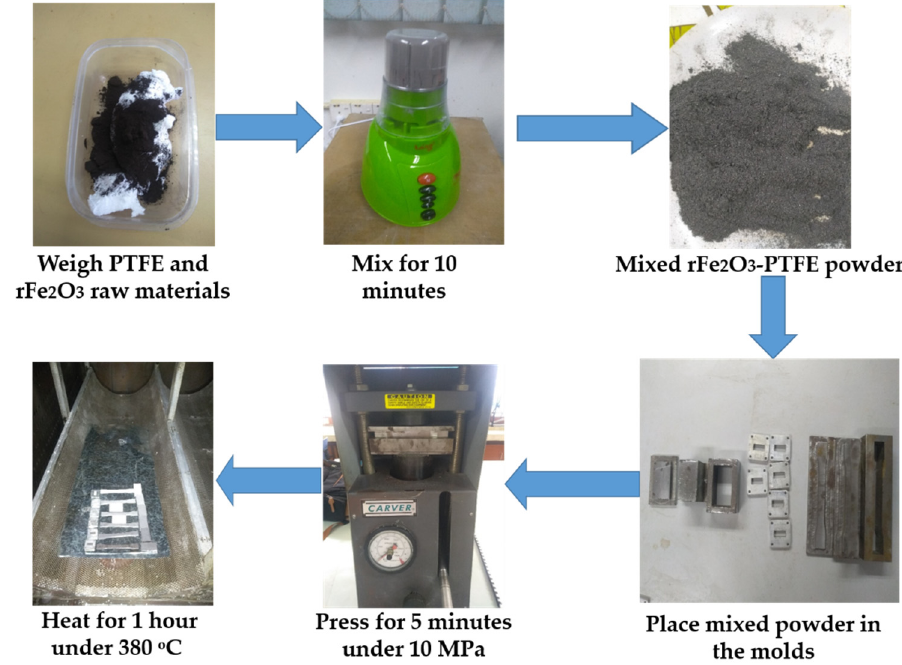
Figure 3. rFe 2 O 3 –PTFE nanocomposites